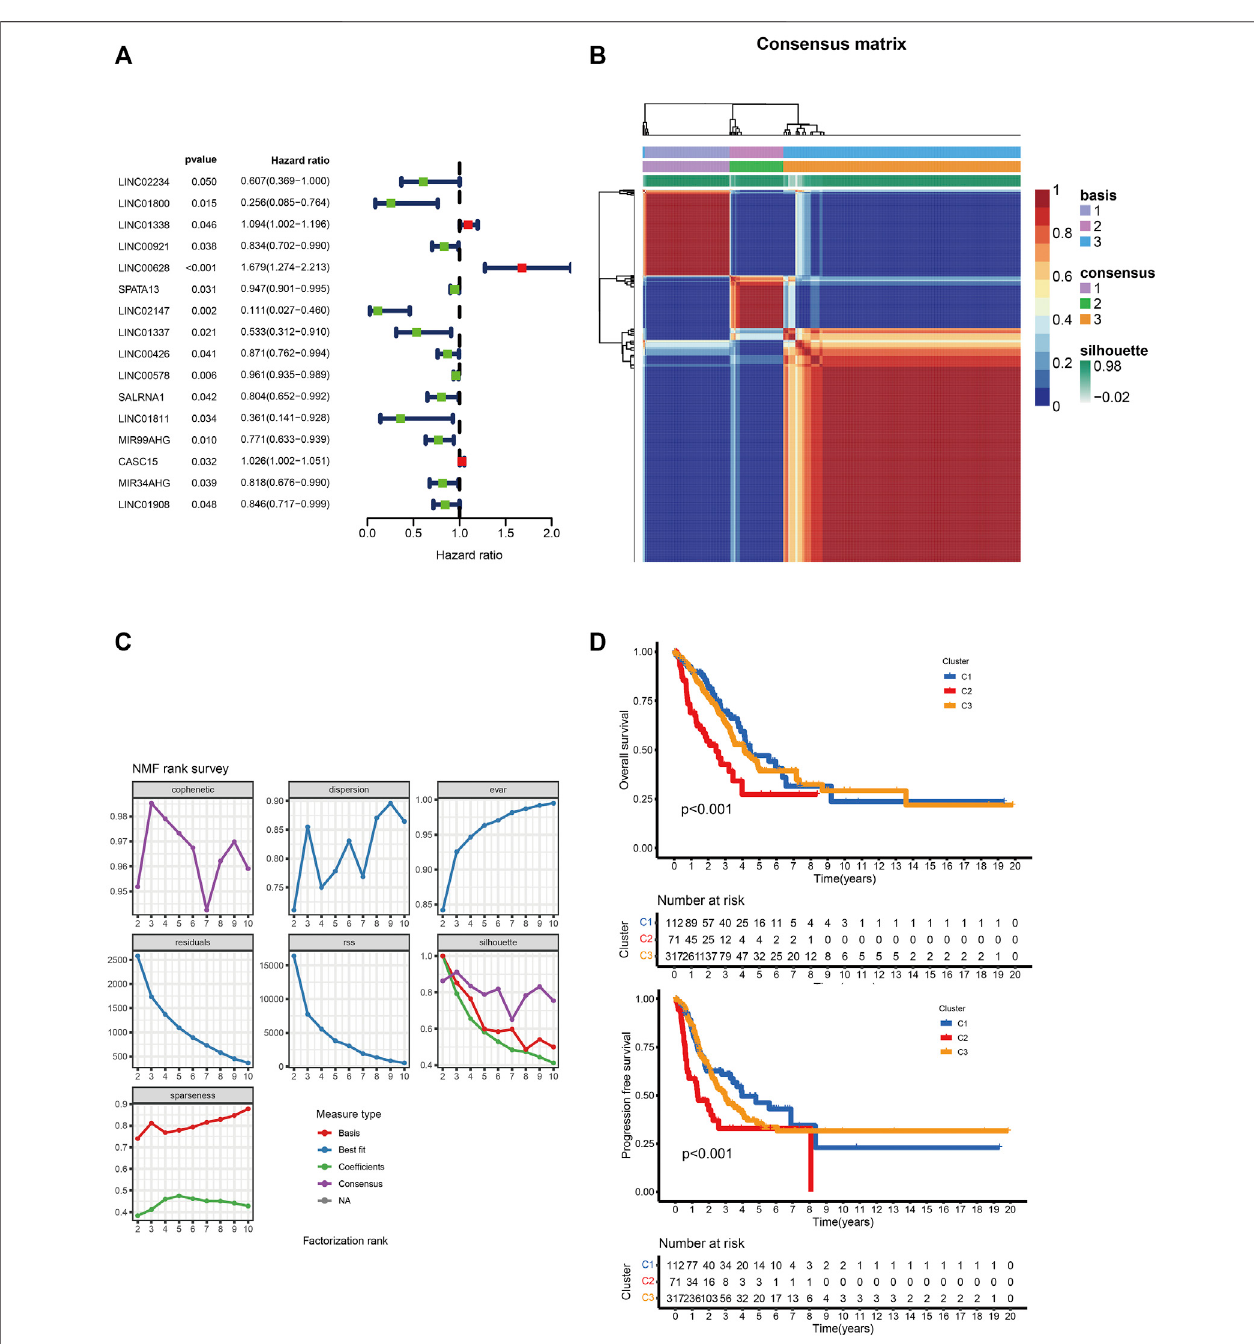
FIGURE1|(A) UnivariateCoxregressionanalysisof16lncRNAsandoverallsurvival. (B) ConsensusmapofNMFclustering. (C) Consensusclusteringparameters. (D) Overall and disease-free survival of C1, C2 and C3 clusters.